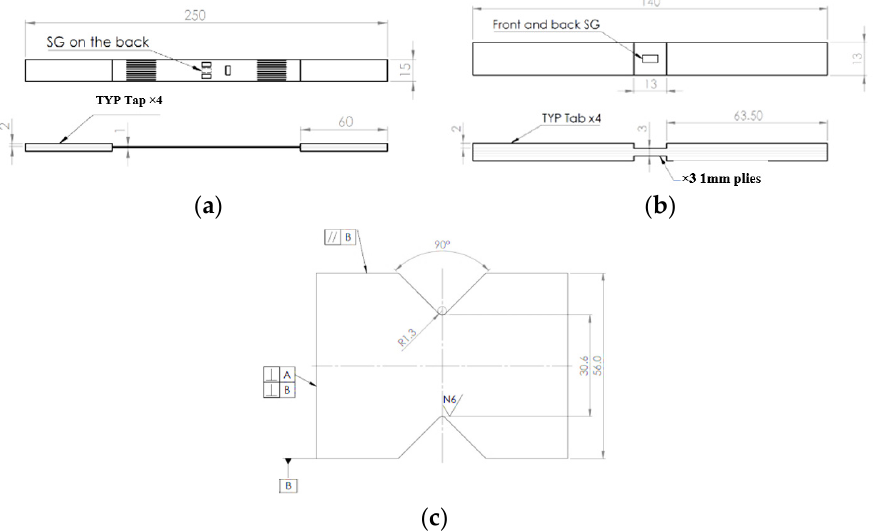
Figure 1. Coupon dimensions and SG location, for each mode of loading; ( a ) tension; ( b ) compression; ( c ) shear.